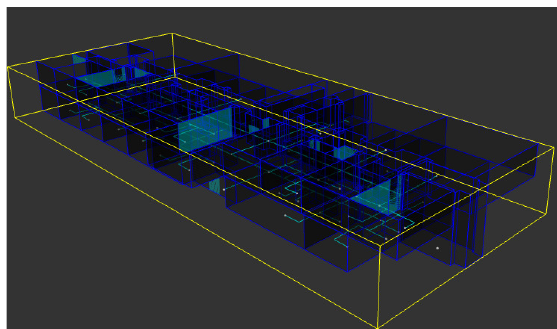
Figure 9. View of the indoor model of the main building of the use case with IndoorGML-Viewer.